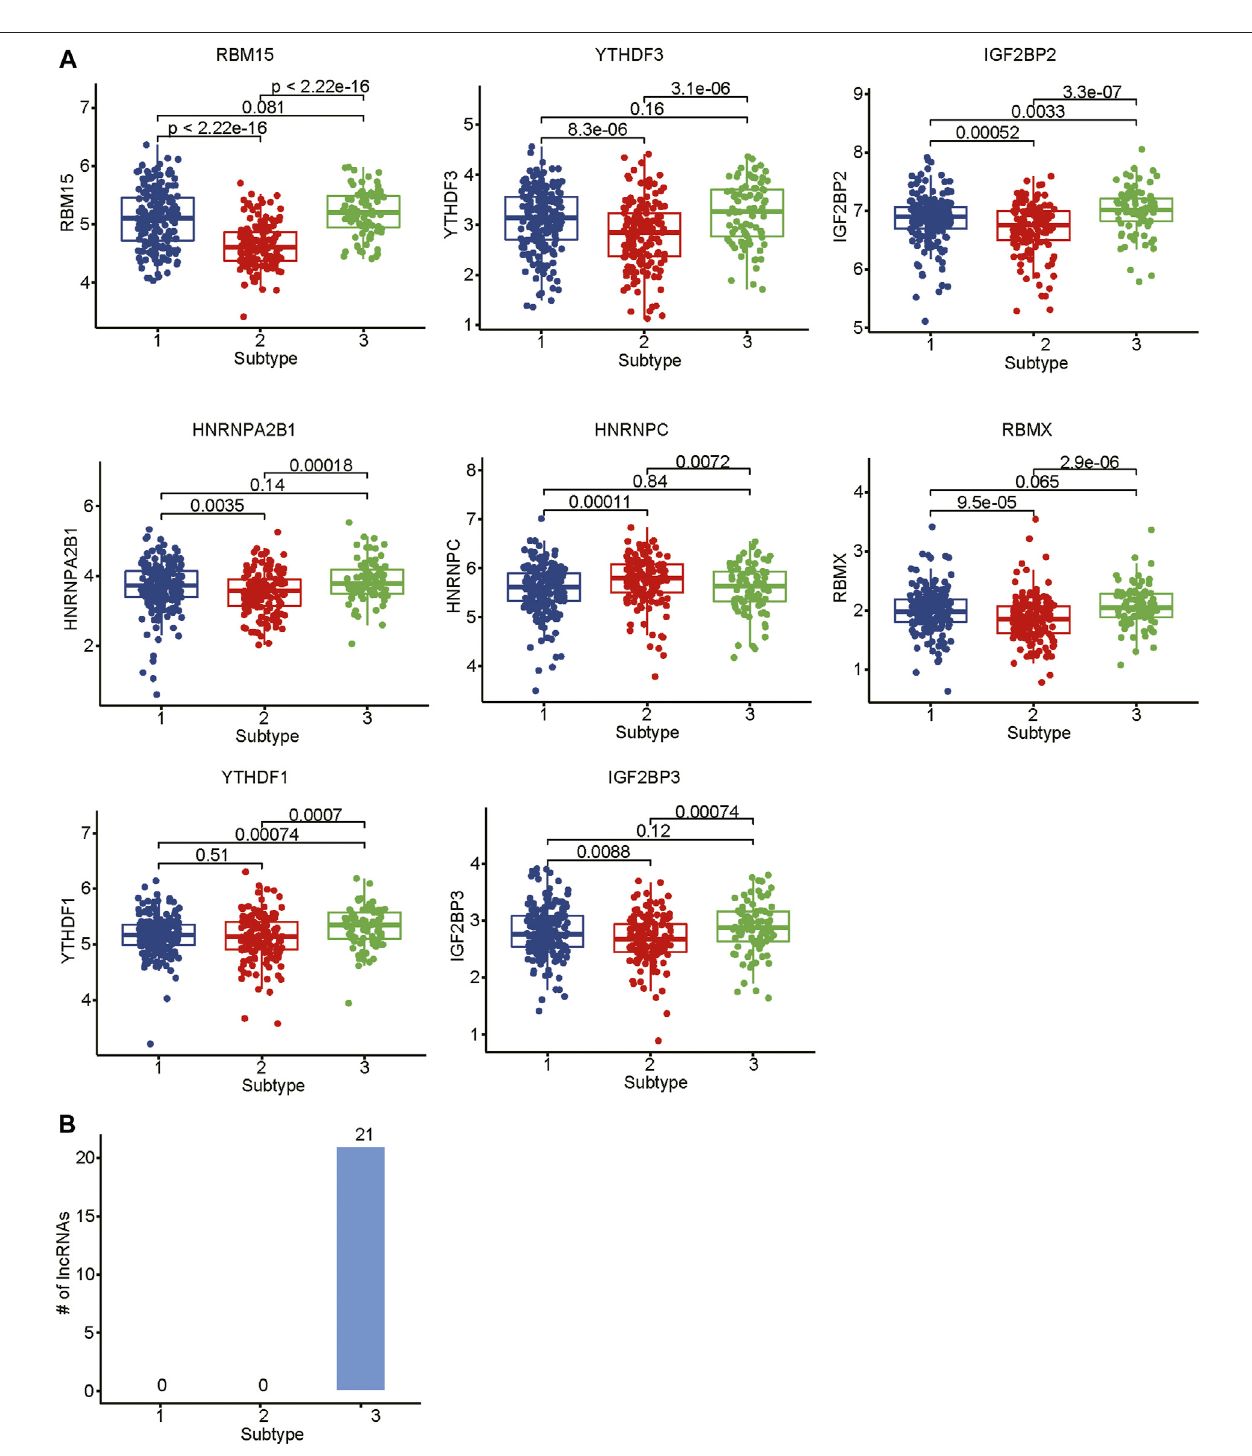
FIGURE 5 | The differential expression levels of m6A regulators and the related lncRNAs among the subtypes. (A) The expression levels of m6A regulators in the three subtypes. (B) The number of differentially expressed lncRNAs in the three subtypes.